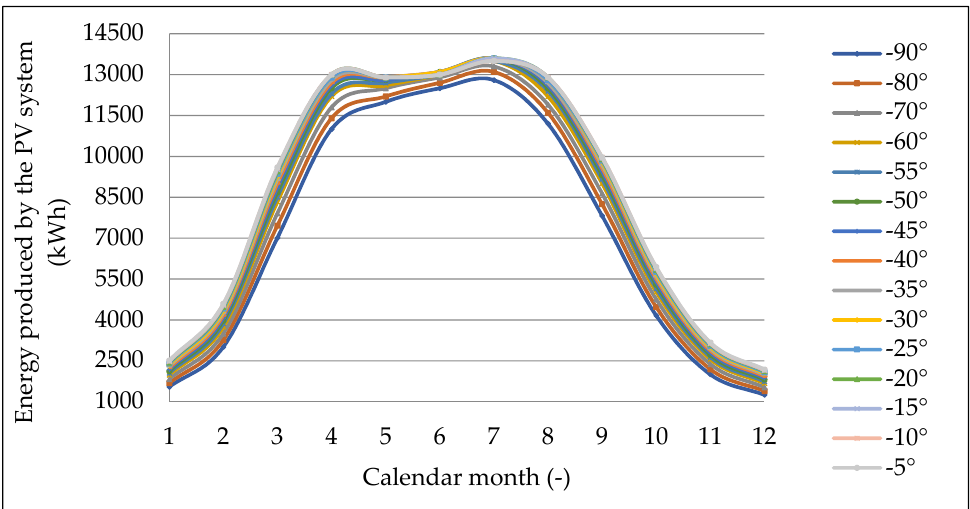
Figure 11. Dependencies of energy produced by the PV system for azimuth angle from − 90° to 0° in different calendar months.